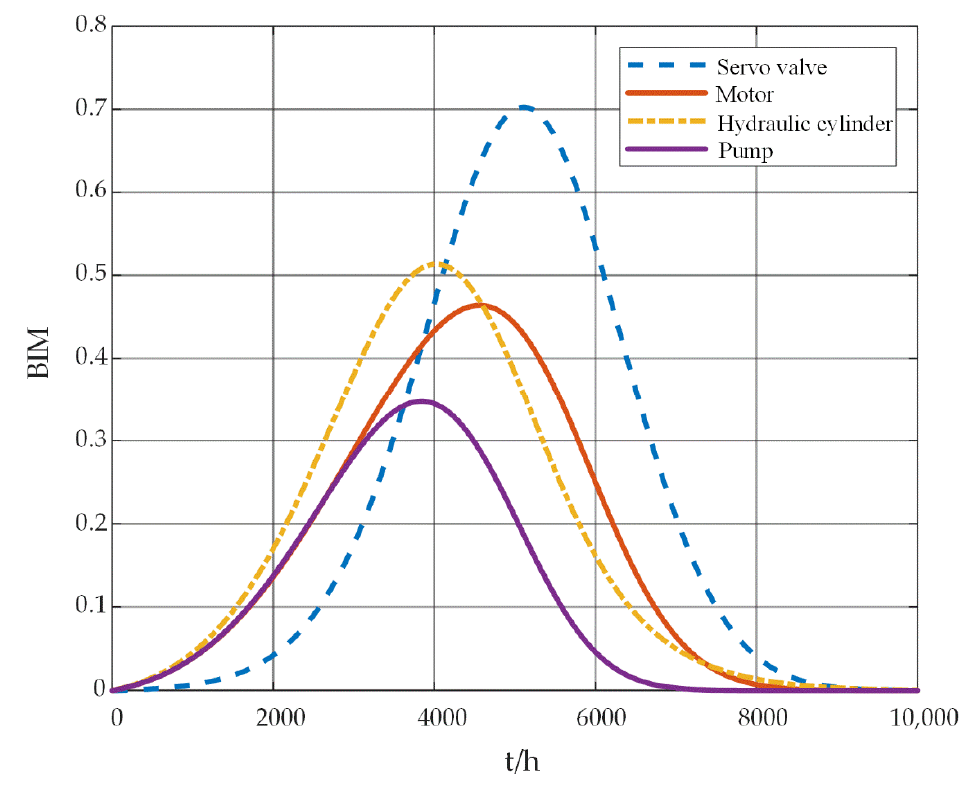
Figure 4. BIM values of the key components in the DRAS change over time.